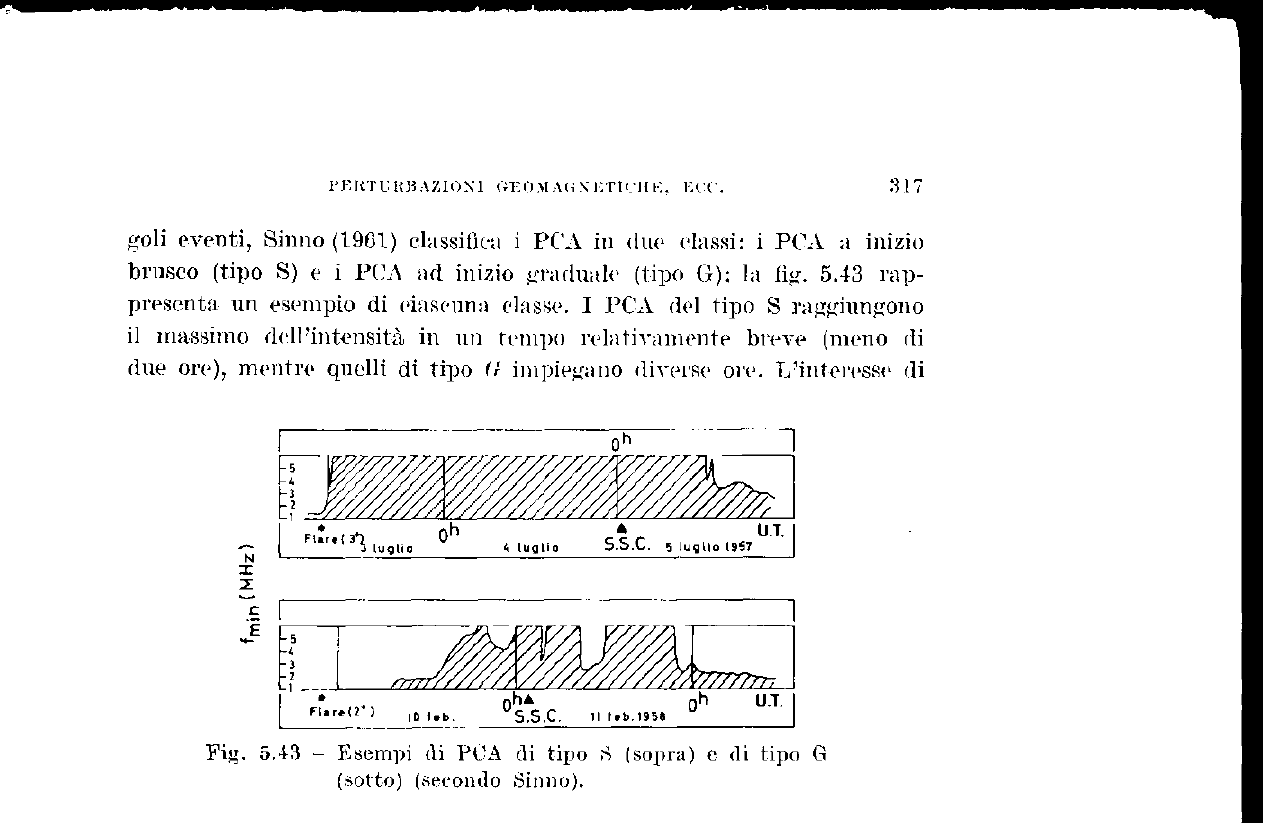
Fig. 5.43 - Esempi di PCA di tipo S (sopra) e di tipo G (sotto) (secondo